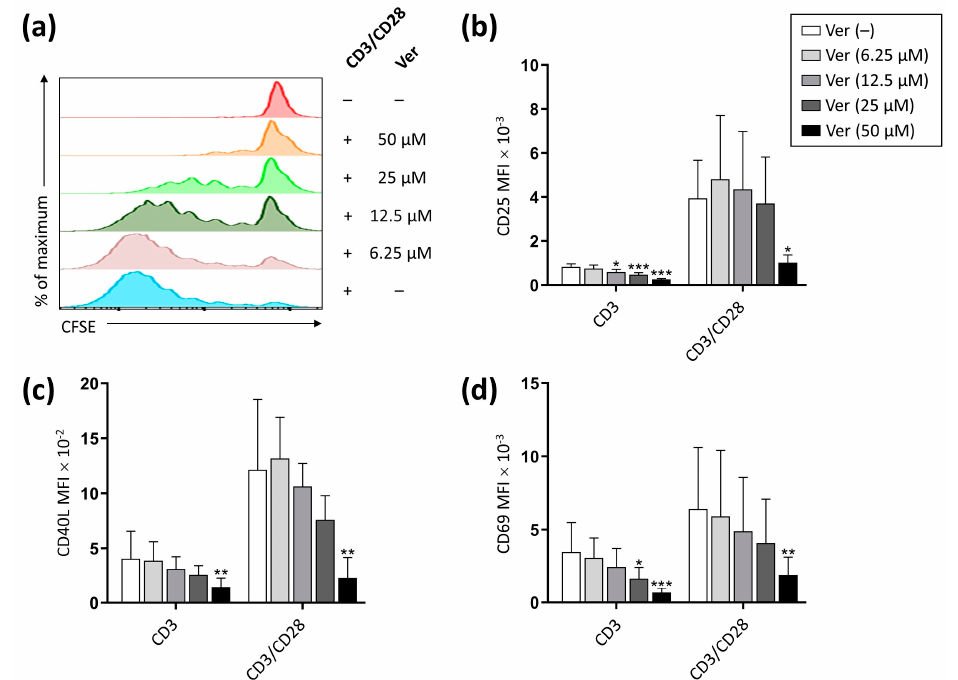
Figure 1. Verapamil inhibits T cell proliferation and activation in a dose-dependent manner. Purified T cells were stimulated (CD3 alone or CD3/CD28) in the absence or presence of different concentrations of verapamil (6.25–50 µ M). ( a ) Cell proliferation was evaluated by CFSE dilution after 120 h of culture. Cells were stained after 24 h of culture for ( b ) CD25, ( c ) CD40L, and ( d ) CD69. Expression level of the activation-induced cell surface molecules is expressed as MFI. Data from 4 donors are shown as mean + SD. The significance of the pairwise comparisons between cells cultured without and with verapamil is indicated with asterisks (* p < 0.05, ** p < 0.01, *** p <